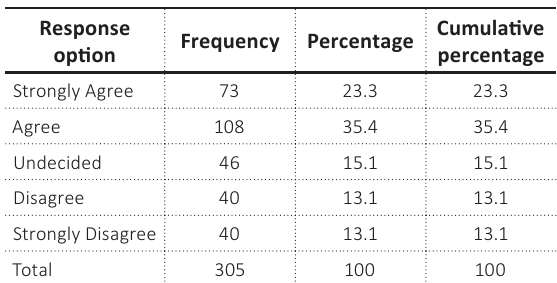
Table 14. Having to participate in banking activities outside of regular working hours is very stressful for me